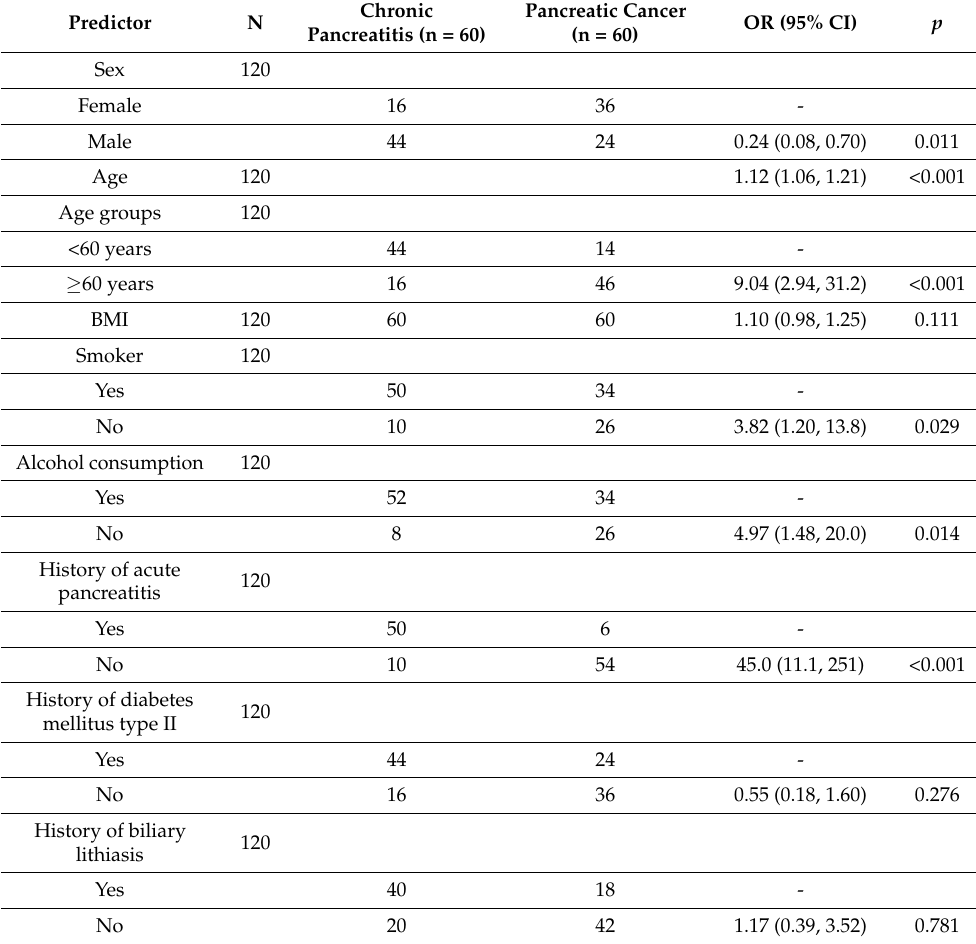
Table 1. Epidemiological and clinical parameters in patients with pancreatic cancer vs. chronic pancreatitis.